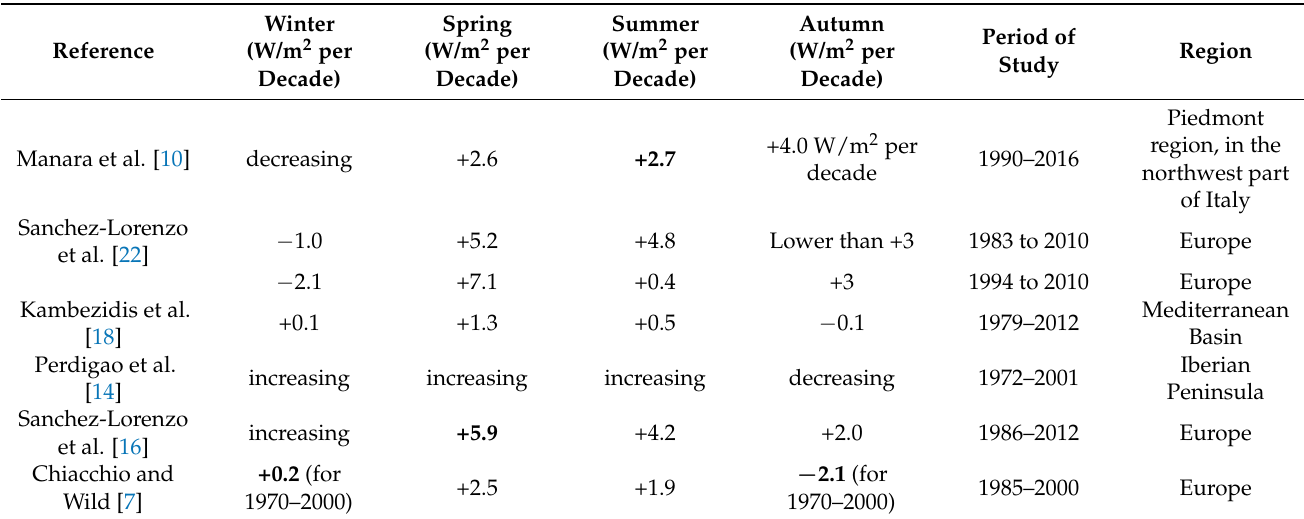
Table 1. Summary of seasonal SWGI trends for various locations in Europe. Bold values indicate significance at the 95% confidence